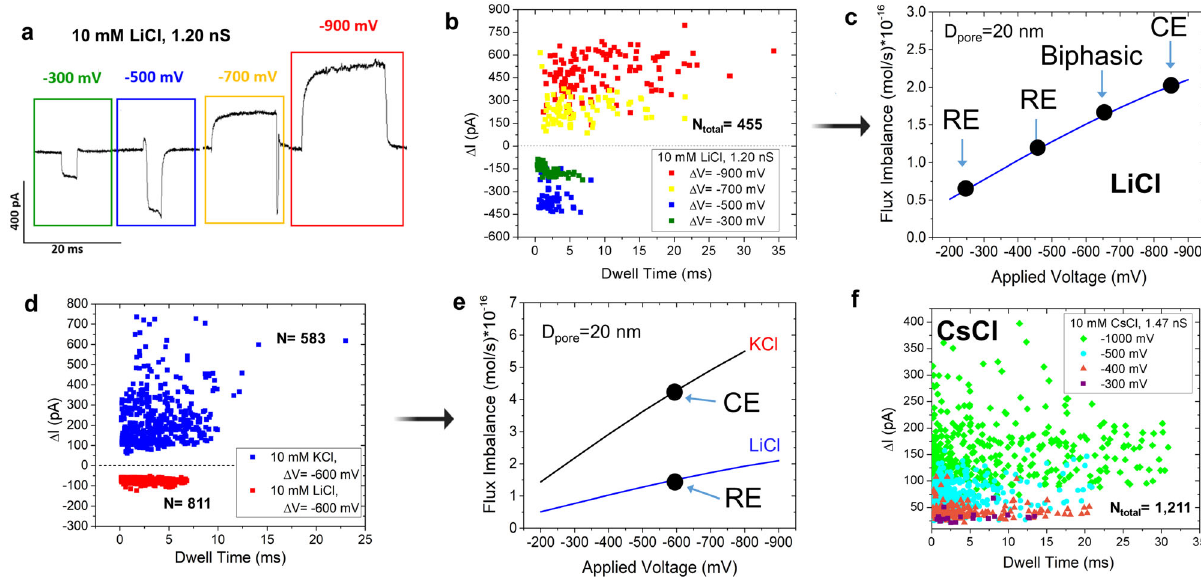
Fig. 4 Event shape characteristics of λ -DNA via various monovalent salts. a Representative waveforms observed in 10 mM LiCl from λ -DNA translocations in response to negative voltages. As the voltage increases in negativity, events transition from resistive to conductive. b Scatterplot showing current change and dwell time relationship with applied voltage for λ -DNA in 10 mM LiCl through a pore with a conductance of 1.2 nS at four different voltages: − 900 mV in red, − 700 mV in yellow, − 500 mV in blue, and − 300 mV in green. c Flux imbalance with (negative) applied voltage in 10 mM LiCl and its in fl uence on the waveform generated through λ -DNA translocations. d An additional scatter plot corresponding to λ -DNA translocation in 10 mM KCl (CEs) and 10 mM LiCl (REs) in response to − 600 mV. Both pores have a pore diameter estimated to be 33 ± 3 nm. The horizontal dashed line corresponds to the fl ux imbalance corresponding to the transition of REs to CEs. e Flux imbalance with (negative) applied voltage in 20 nm diameter pores in 10 mM KCl and LiCl. f Scatter plot of current change and dwell time corresponding to λ -DNA translocation in 10 mM CsCl in various applied voltages. All voltages produced CEs, similar to